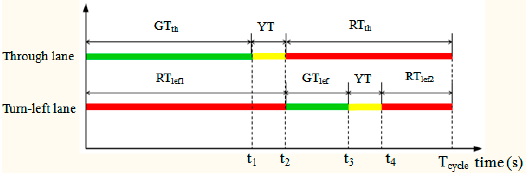
Figure 4. Block diagram of the control system.